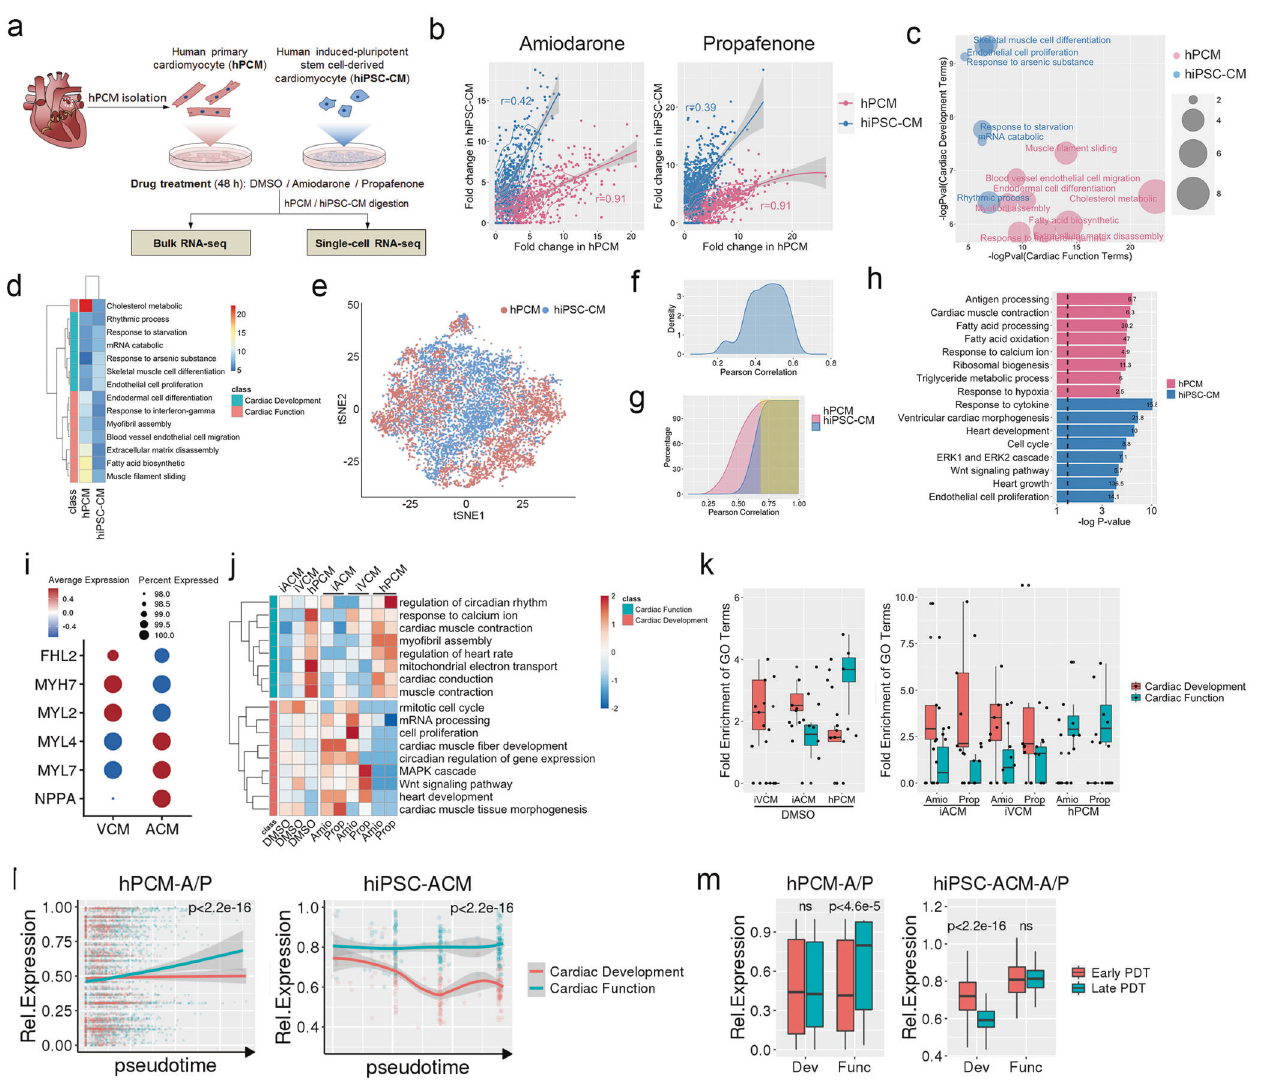
Fig. 7 hPCMs display signi fi cant transcriptomic signatures of cardiac function in response to amiodarone and propafenone. a Schematic of study design. Human primary cardiomyocytes (hPCMs) from fi ve donors and human-induced pluripotent stem cell-derived cardiomyocytes (hiPSC-CMs) from three individuals were treated with indicated drugs for 48 h, and their gene expression changes were detected by both bulk and single-cell RNA sequencing (scRNA-seq). b The transcriptome responses to amiodarone (top) or propafenone (bottom) in hPCMs or hiPSC- CMs, compared to their basal levels (DMSO). The density plots show the fold changes of differentially expressed genes (DEGs) in response to drugs, overlapped with base-level (DMSO) hPCM- or hiPSC-CM-speci fi c genes. c Gene ontology (GO) analysis of the DEGs from ( b ). Selected top enrichment terms of overlapping DEGs between amiodarone and propafenone treatment in hPCMs (red) and hiPSC-CMs (blue) are shown. d Heatmap showing hierarchical clustering of the GO terms from ( c ) by fold enrichment. e t -distributed stochastic neighbor embedding ( tSNE ) visualization of 10,478 single cells from cultured hPCMs (red) and hiPSC-CMs (blue) treated with DMSO, amiodarone, or propafenone. f The distribution of Pearson correlations of the single-cell transcriptomes between hPCMs and hiPSC-CMs. g The stacks of Pearson correlations from F, showing cell-cell similarities of hPCMs and hiPSC-CMs, respectively. R 2 > 0.6 was considered a high similarity (highlighted in yellow). h GO analysis of overlapping DEGs between amiodarone and propafenone treatment in hPCMs (red) and hiPSC-CMs (blue). The hPCMs and hiPSC-CMs were extracted from G with a cutoff of R 2 > 0.6. i Dotplot showing the expression levels of atrial and ventricular marker genes of VCMs and ACMs, and their respective fractions. j , k Heatmap showing the z -scores ( j ) and boxplots ( k ) showing the fold enrichment of selected top GO terms of the DEGs in response to amiodarone (Amio) or propafenone (Prop) treatments in hiPSC-ACMs (i-ACM), VCMs (i-VCM) and hPCMs. l hPCMs (left) or hiPSC-CMs (right) ordered by pseudotime in response to amiodarone and propafenone treatment. Smoothed lines indicate the expression of cardiac function- or development-related genes along the trajectories upon drug treatment. m Boxplots showing the expression levels of cardiac function- or development-related genes in early or late pseudotime of hPCMs (left) or hiPSC-CMs (right), respectively. Early PDT: the fi rst 10% cells in the pseudotime axis from N; Late PDT: the last 10% cells in the pseudotime axis from N. Dev: cardiac development-related genes; Func: cardiac function-related genes FHL2 , and MYL2 ) marker genes (Supplementary Fig. S8 and Fig. 7i). progression, while the hPCM-dominant cluster K6 were primarily Speci fi cally, cells with high levels of atrial marker expression and related to cardiac muscle function (Supplementary Fig. S7n). low levels of ventricular marker expression were identi fi ed as atrial- For a fair comparison between hiPSC-CMs and hPCMs, we sorted like hiPSC-CMs (ACMs), whereas cells with low levels of atrial out CM subtypes within hiPSC-CMs, and strati fi ed them by the marker expression and high levels of ventricular marker expression expression of atrial ( NPPA , MYL7 , and MYL4 ) and ventricular ( MYH7 , Signal Transduction and Targeted Therapy (2022)